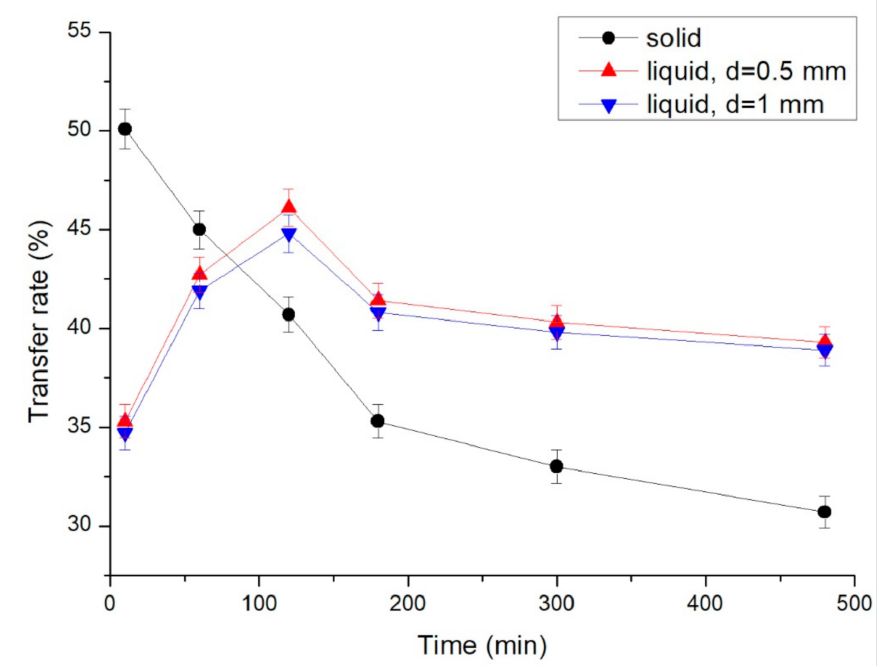
Figure 13. Optical/electric power transfer rate of the LED chip with various conductors and distances between